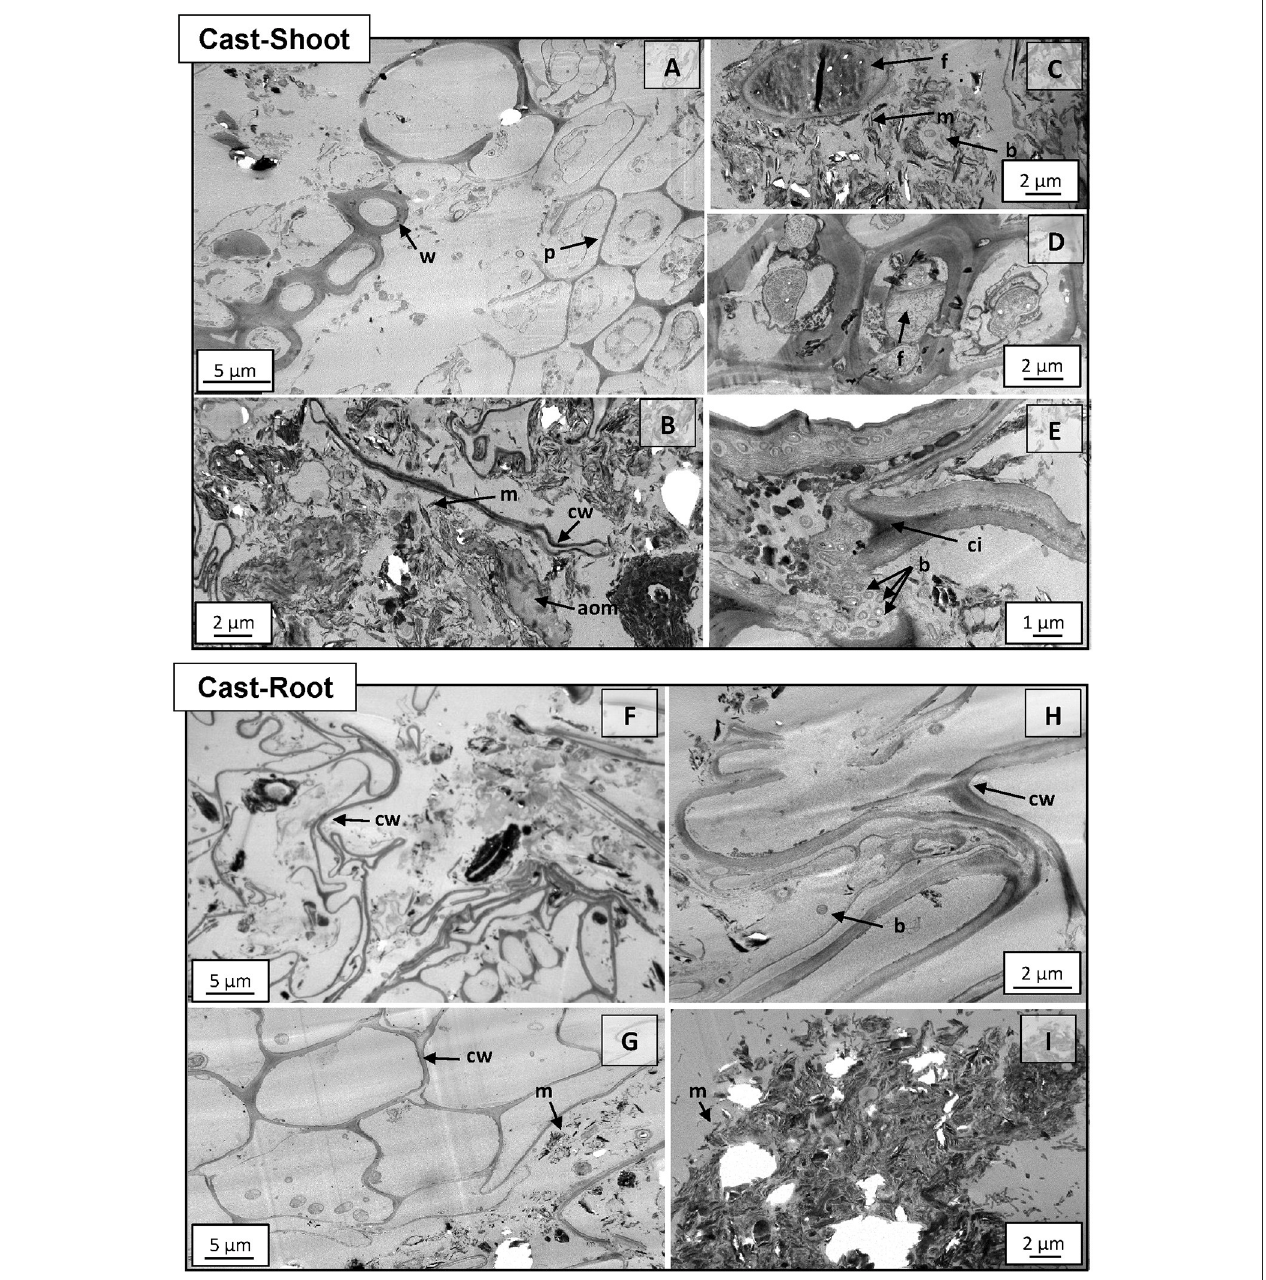
FIGURE 3 | TEM micrographs of Cast-Shoot and Cast-Root samples after 8 weeks of experiment. (A) Partially degraded parenchyma cells and well-preserved woody tissues; (B) organo-mineral aggregate; (C) fungus in an organo-mineral aggregate; (D) fungi attacking woody tissues; (E) bacteria inside cell walls; (F,H) compacted cell walls; (G) intact cell walls and (I) organo-mineral aggregate dominated by mineral particles. aom, amorphous organic matter; b, bacteria; cw, cell wall; ci, cell intersection; f, fungus; m, mineral particle; p, parenchyma cell; w, woody tissue.